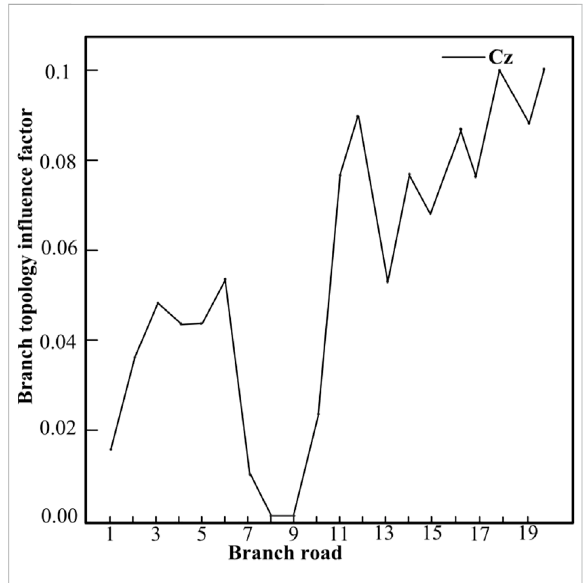
FIGURE 7 Branch topology in fl uence factor Fig.8 Branch connectivity impact